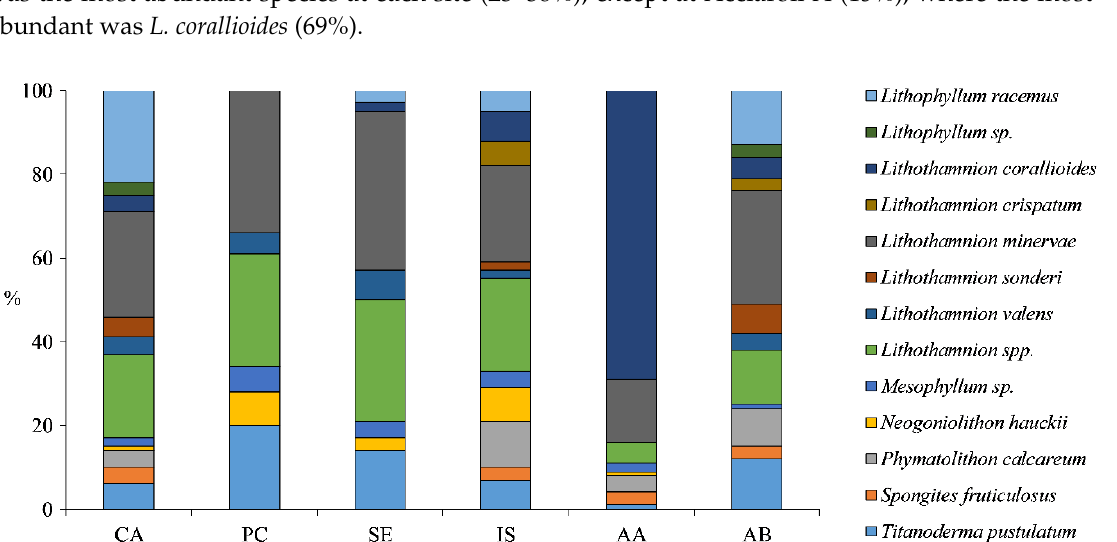
Figure 8. Coverage (%) of CA taxa at each site. CA, Capri; PC, Punta Campanella; SE, Secchitiello; IS, Ischia; AA, Acciaroli A; AB, Acciaroli B.